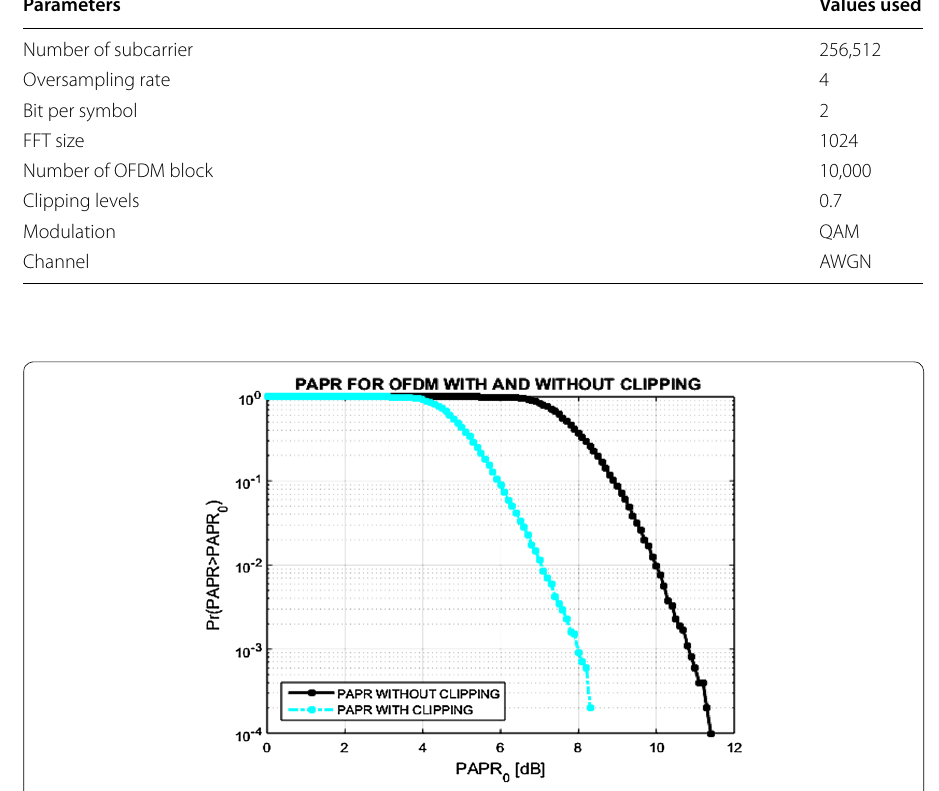
Fig. 1 Representation of CCDF of PAPR of clipping and conventional OFDM